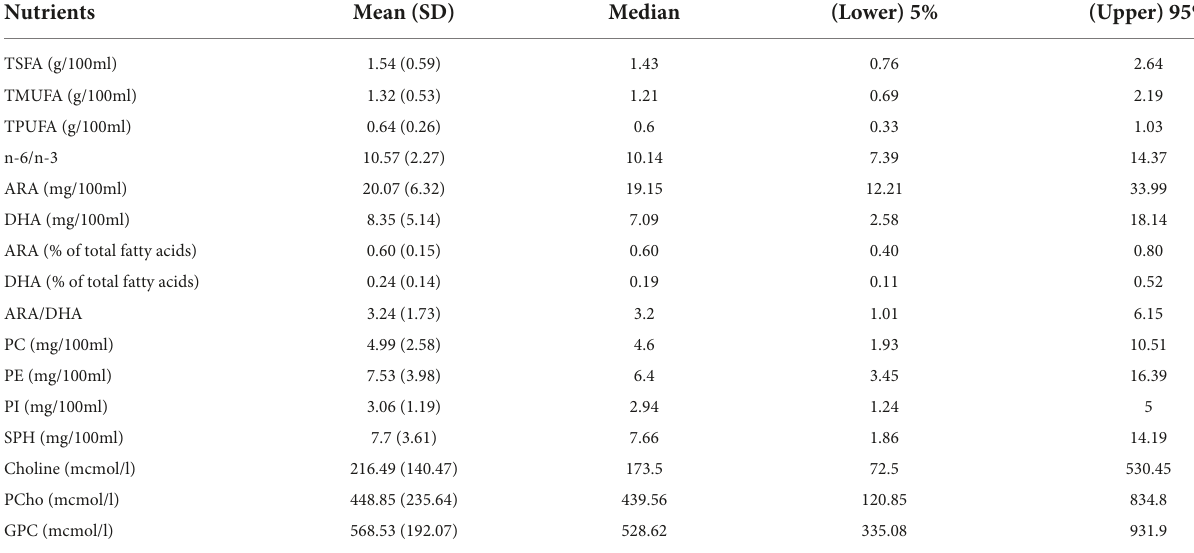
TABLE 2 Composition of fatty acids, phospholipids, and choline metabolites in human milk in the first six postpartum months. Nutrients Mean (SD)